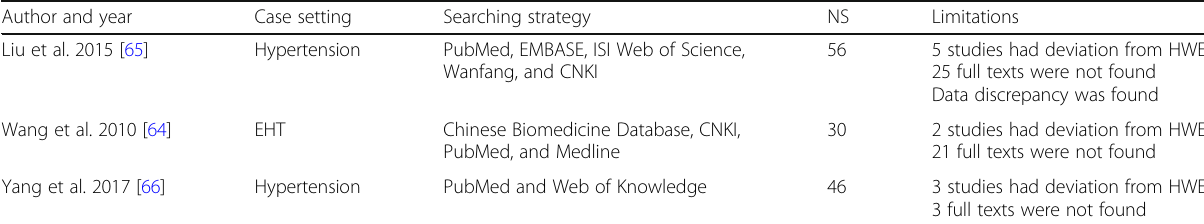
Table 3 Summary of previous meta-analyses and the